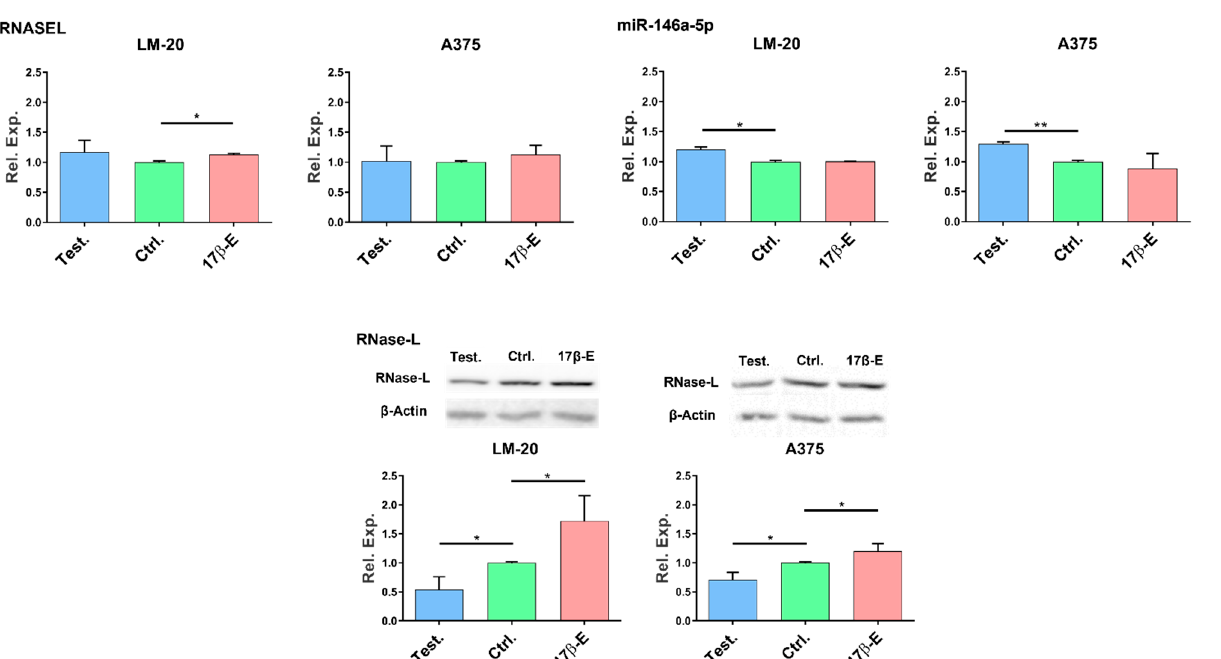
Figure 3. Sex hormones affect the endogenous expression of miR-146a, RNASEL, and RNase-L. In LM-20 and A375 cells: ( Top , left panel) RNASEL transcript level in the presence of testosterone or 17 β -estradiol in comparison with control. ( Top , right panel) miR-146a gene expression level in the presence of testosterone or 17 β -estradiol. ( Bottom ) RNase-L protein expression level in the presence of testosterone or 17 β -estradiol. All the results are reported as a mean value ± S.D. Differences in relative expression were analyzed with GraphPad Prism statistical program, using unpaired, two- tailed Student’s t -test: * p < 0.05; ** p < 0.01.